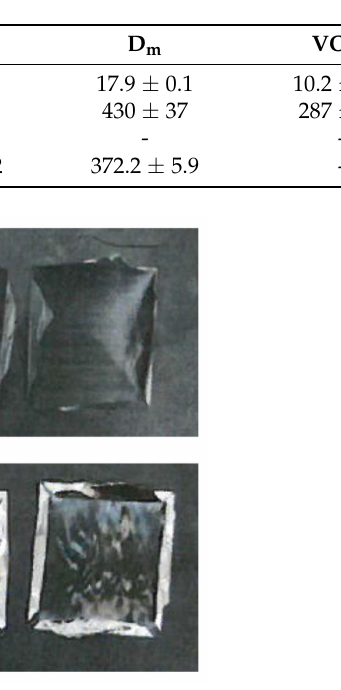
Table 5. Smoke density test results of CF/PPS composites (processing temperatures of 280 ◦ C) and other composites.